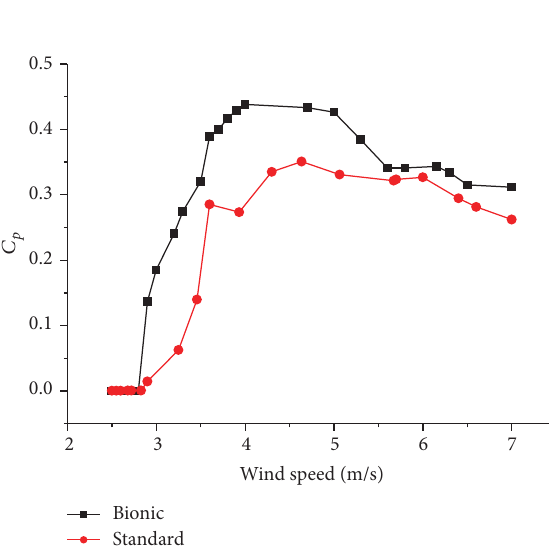
Figure 11: Test system.